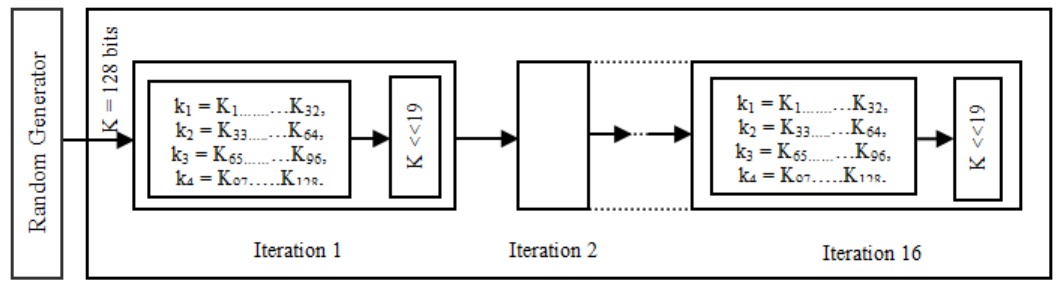
Figure 2. Key Generation Algorithm Diagram